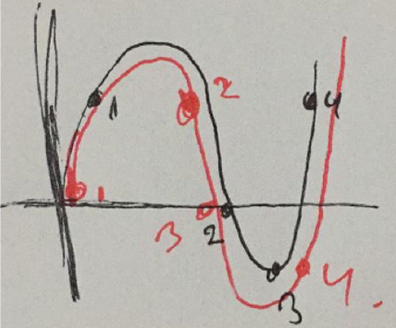
FIG. 13. A student still could not imagine how to draw two identical wave profiles in scaffolding level 3.